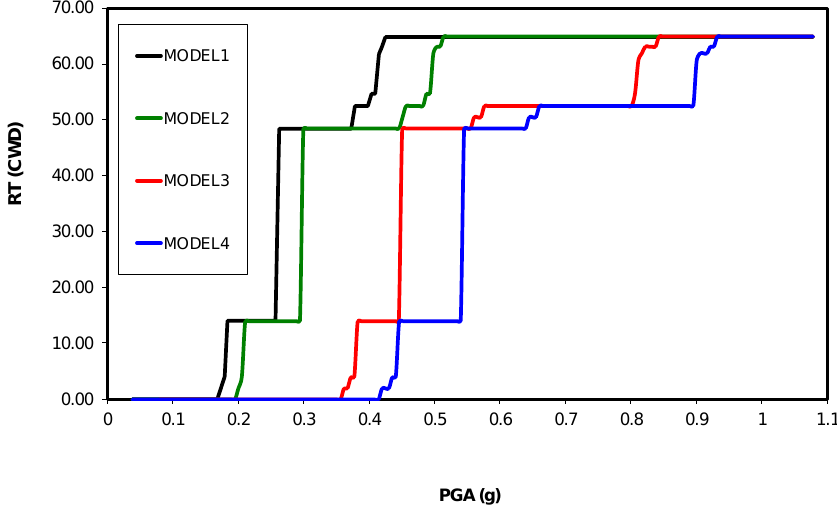
Figure 4. Repair time (RT) calculated by the PBEE